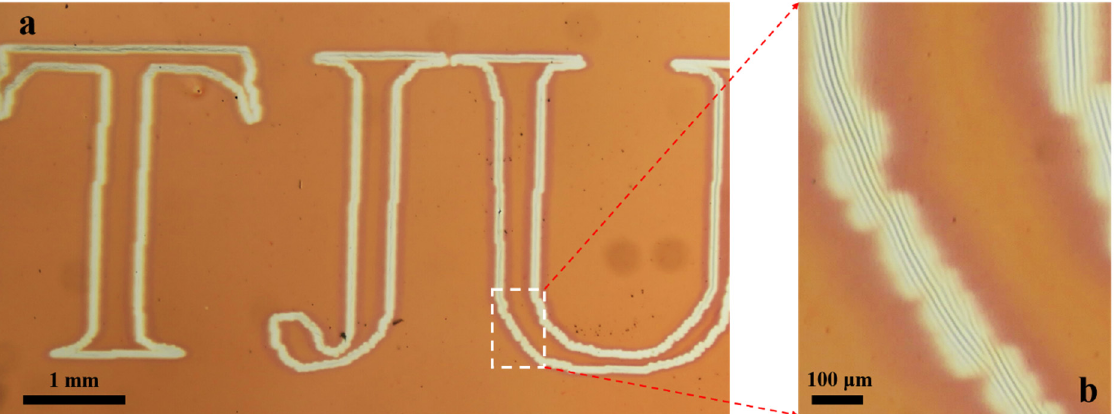
Figure 7. Optical image ( a , b ) of path-guided oriented wrinkles (TJU) of (2% PDO 3 -2% PS)/PDMS induced by a moving high-intensity laser beam (e.g., 16.20 W·cm − 2 /1.0 mm·s − 1 ).